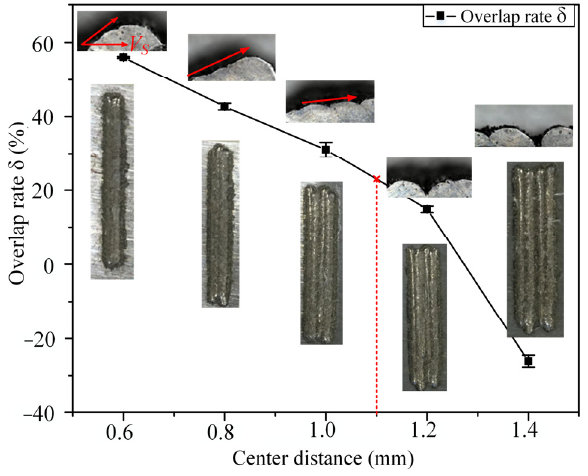
Figure 8. Transverse overlapping.